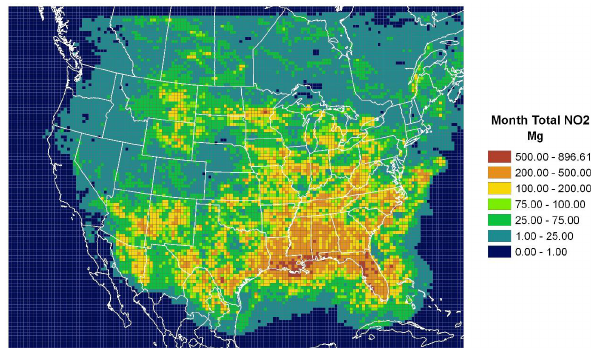
Fig. 1. Total lightning NO x emissions (Mg of NO 2 ) calculated for July 2002 across the atmospheric modeling domain derived from NLDN data.